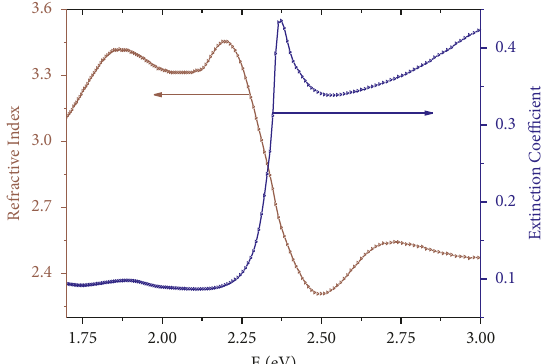
Figure 6: Absorption coefficient and skin depth of the prepared MAPB thin